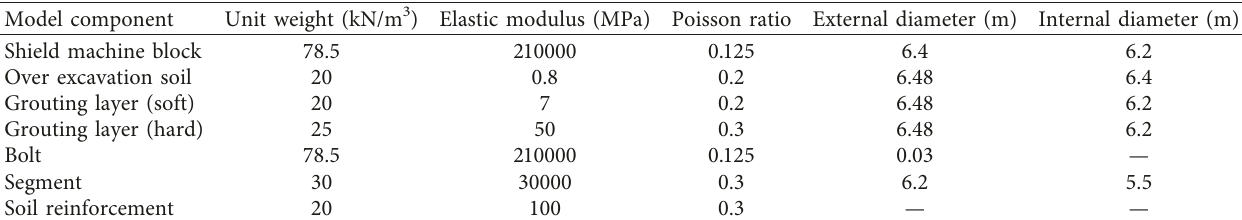
Table 3: Basic parameters of components in the launching-arrival stage of shield tunneling in the XW interval. Model